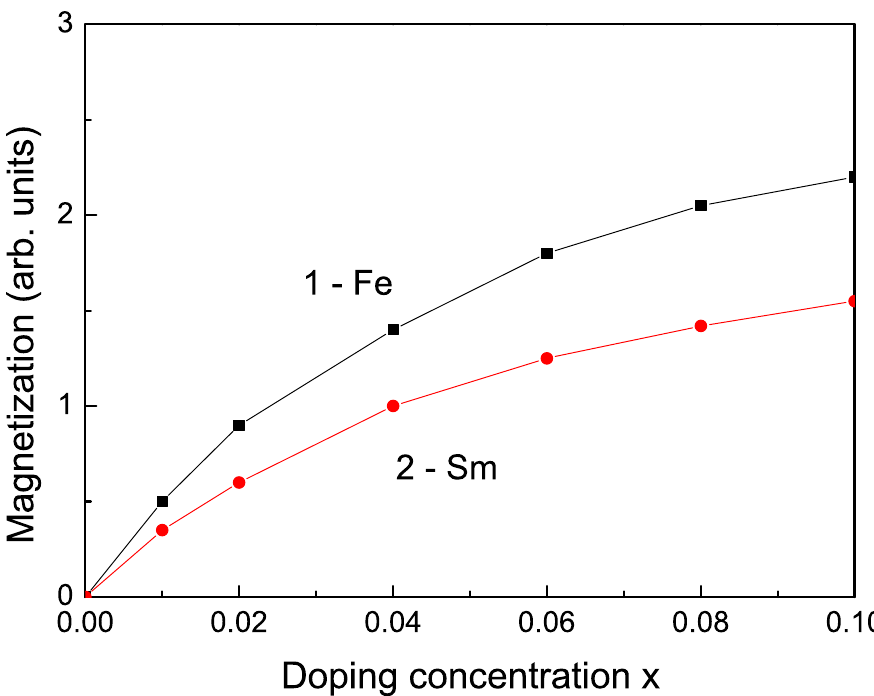
Figure 5. Dependence of the magnetization M on the ion-doping concentration (1) Fe and (2) Sm for J s = 1.2 J b , T = 300 K, for bulk TiO 2 .